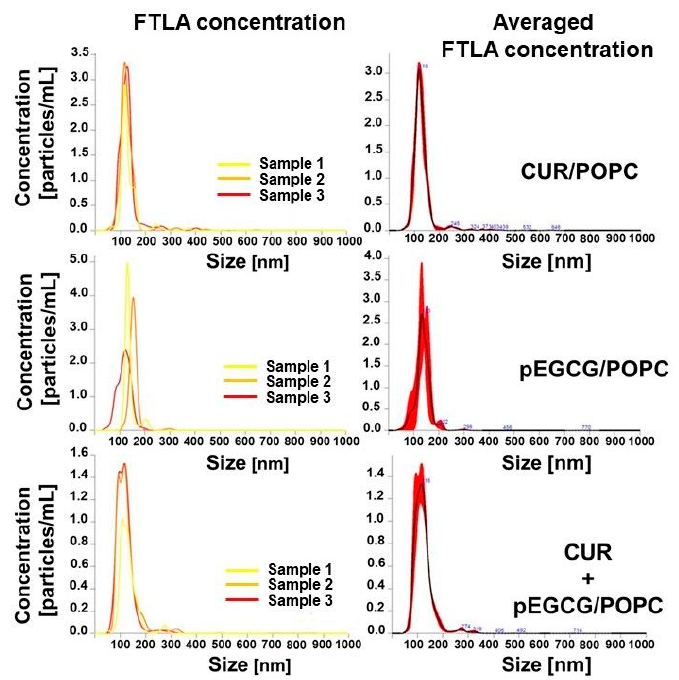
Figure 3. The mean hydrodynamic diameter distribution patterns of the prepared liposomes subjected to biological evaluation. FTLA—the finite track length adjustment. Table 1. The size of the liposomes and their concentration as prepared immediately before the bio- logical activity study.